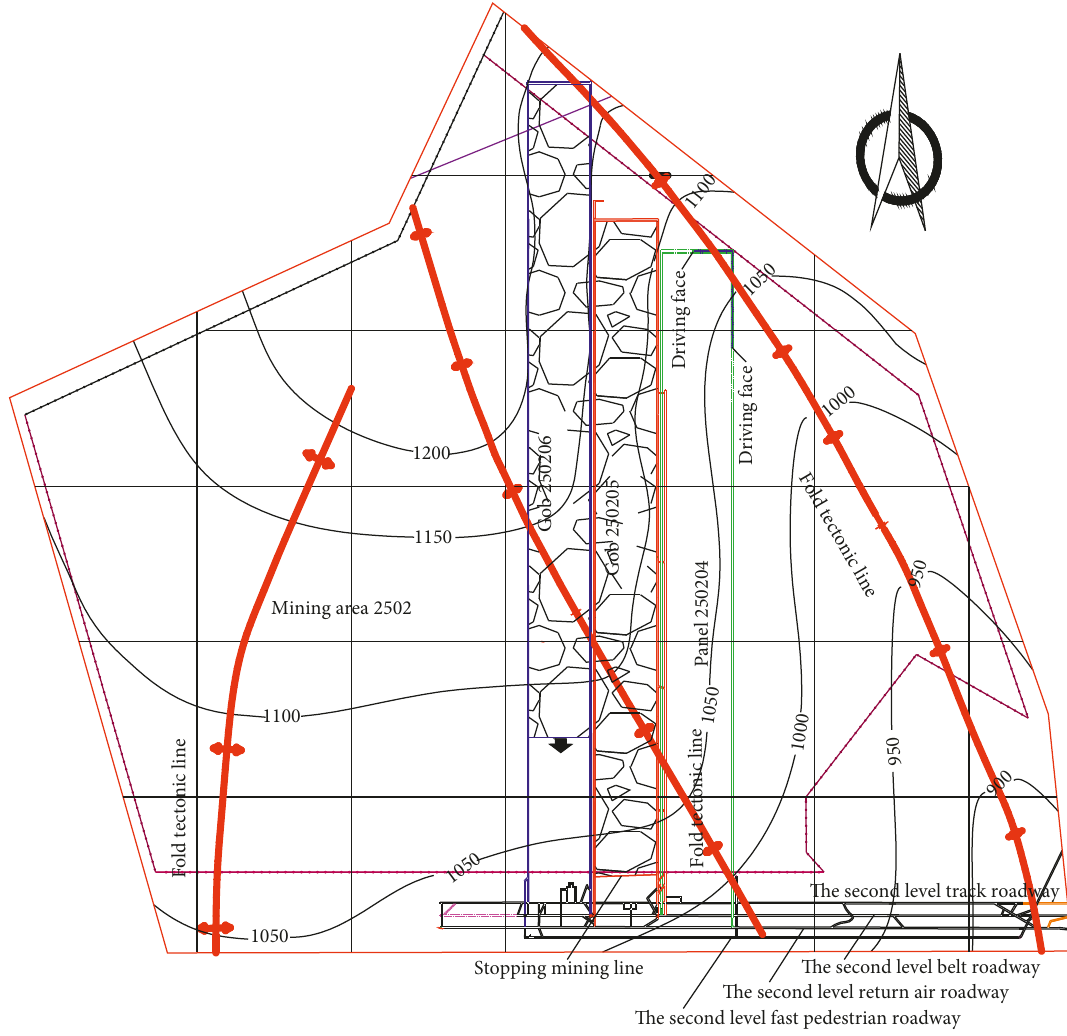
Figure 2: The plan of mining area 2502 of Yanbei coal